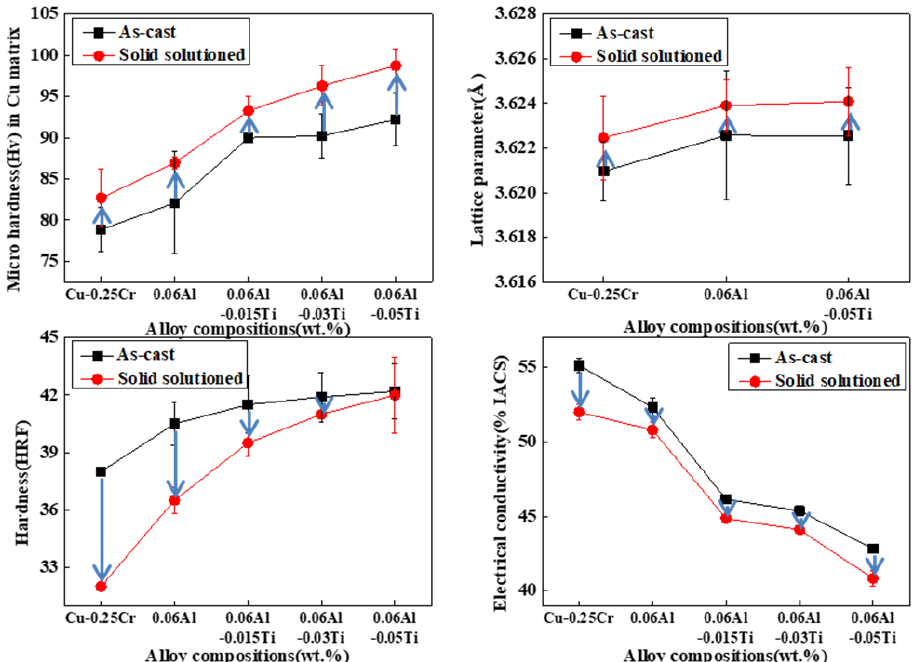
Figure 5. Variation of properties of Cu-Cr alloys as-cast and solid solution treatment.